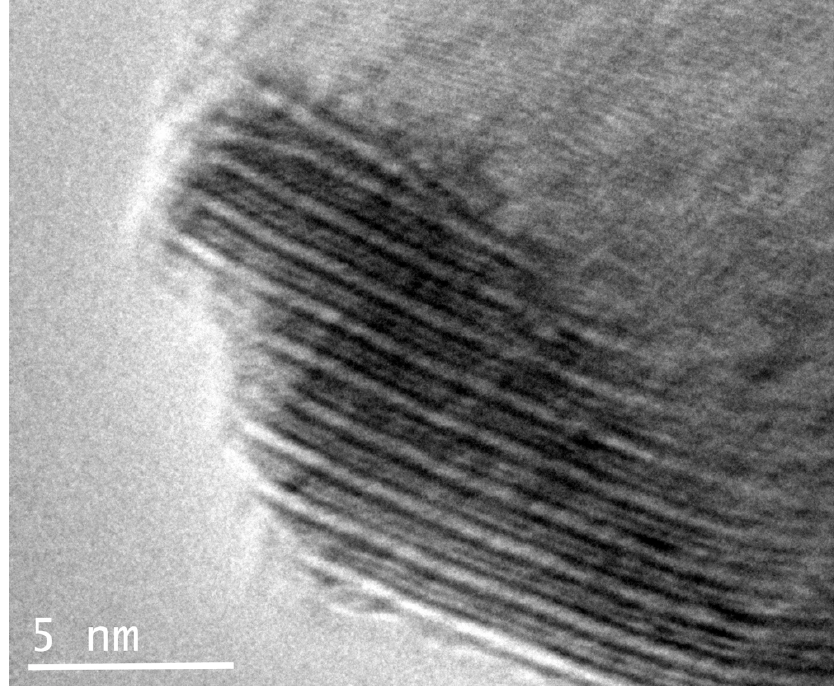
Figure 13. High-resolution TEM image showing the modulated stacking along the c -axis of the PbS-type ( Q ) and MoS 2 -type ( H ) layers. Sample prepared by mechanical crushing of a whisker. The length of the scale bar is approximate. (Sample 3666qf.)